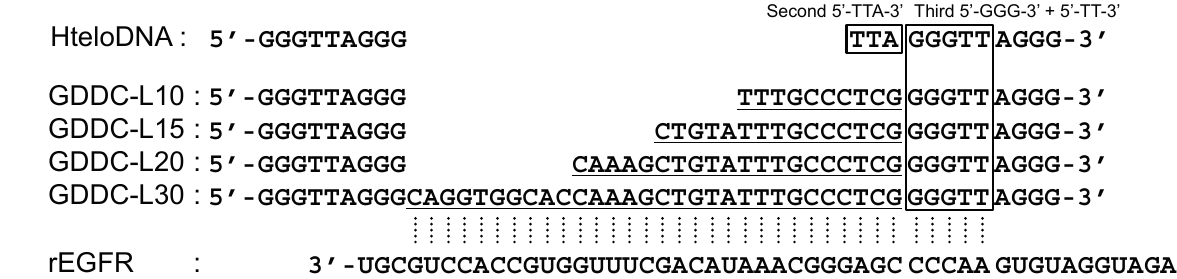
Figure 2. Sequences of HteloDNA and the GDDCs with various loop sequences complementary to rEGFR. The long loop region is underlined. Dashed lines represent the complementary relationship between GDDC and rEGFR.